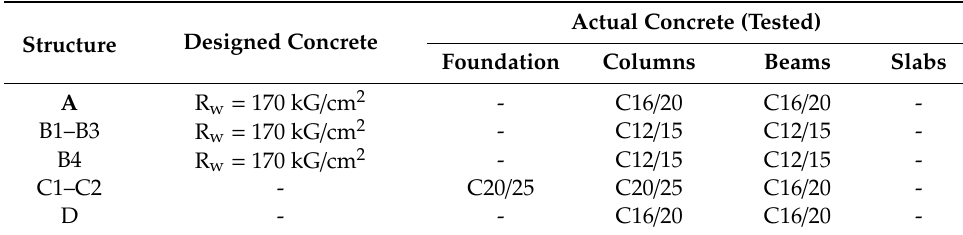
Table 1. Concrete classes—designed and applied (tested).